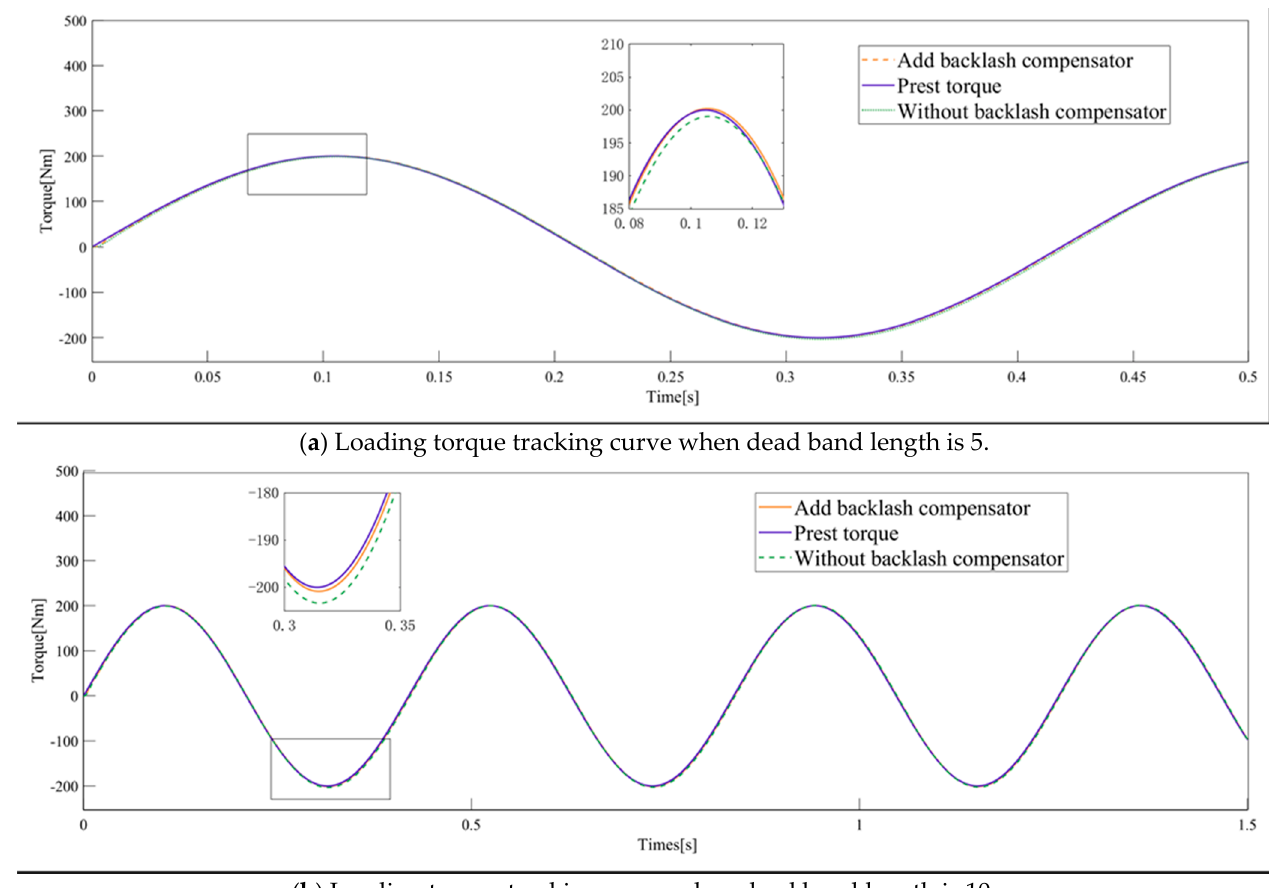
Table 4. Velocity error of different backlash.